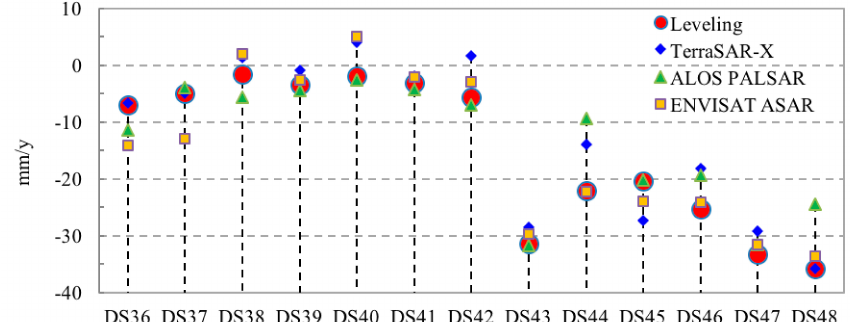
Figure 9. Validation of InSAR-derived mean deformation rates at leveling